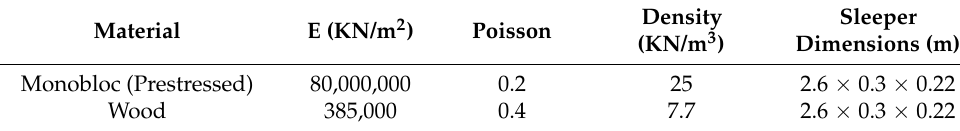
Table 4. Material properties for the different sleepers used in the analysis.